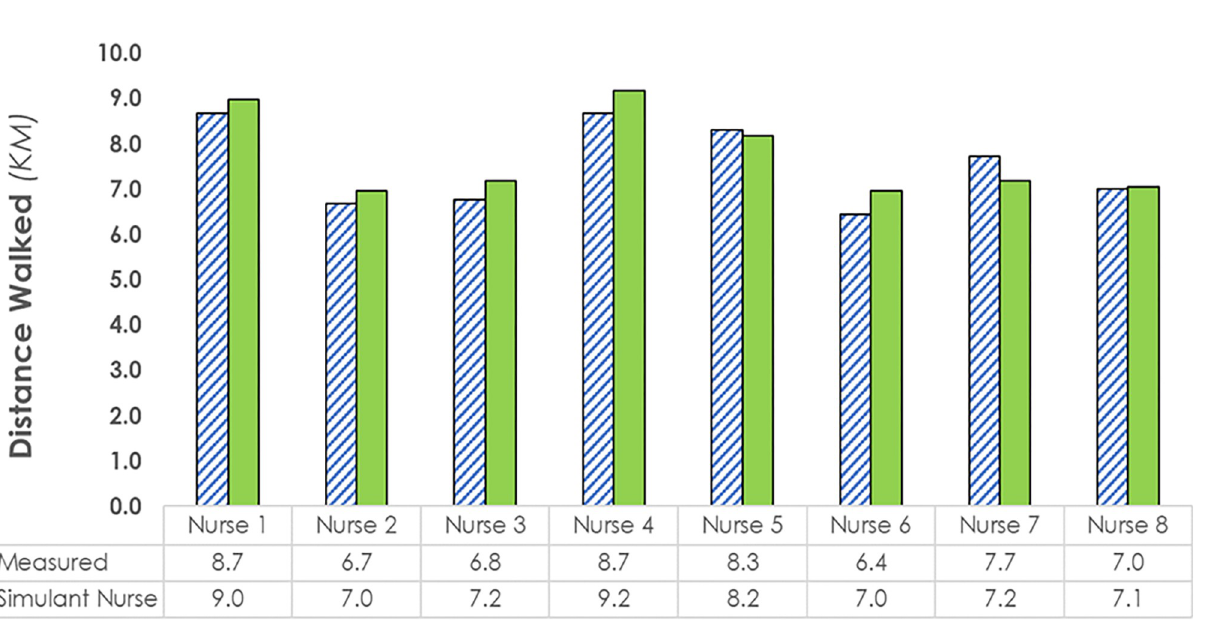
PLOS ONE | https://doi.org/10.1371/journal.pone.0275890 October 13,